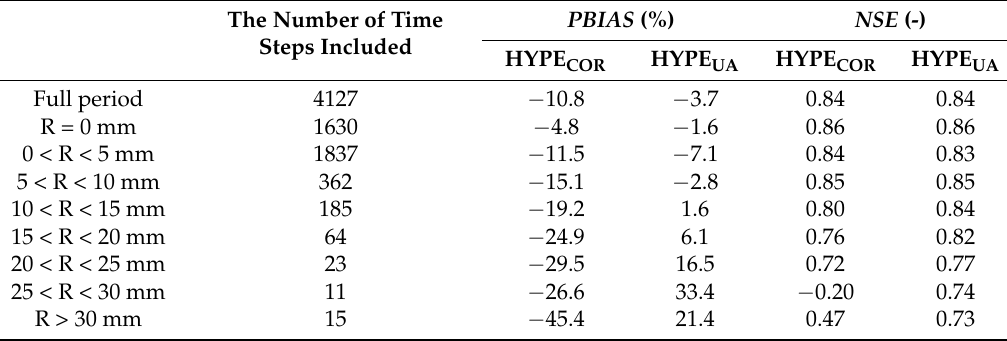
Table 3. Model performance calculated for the period from 1 January 2001 to 31 December 2013. The Number of Time PBIAS Steps Included